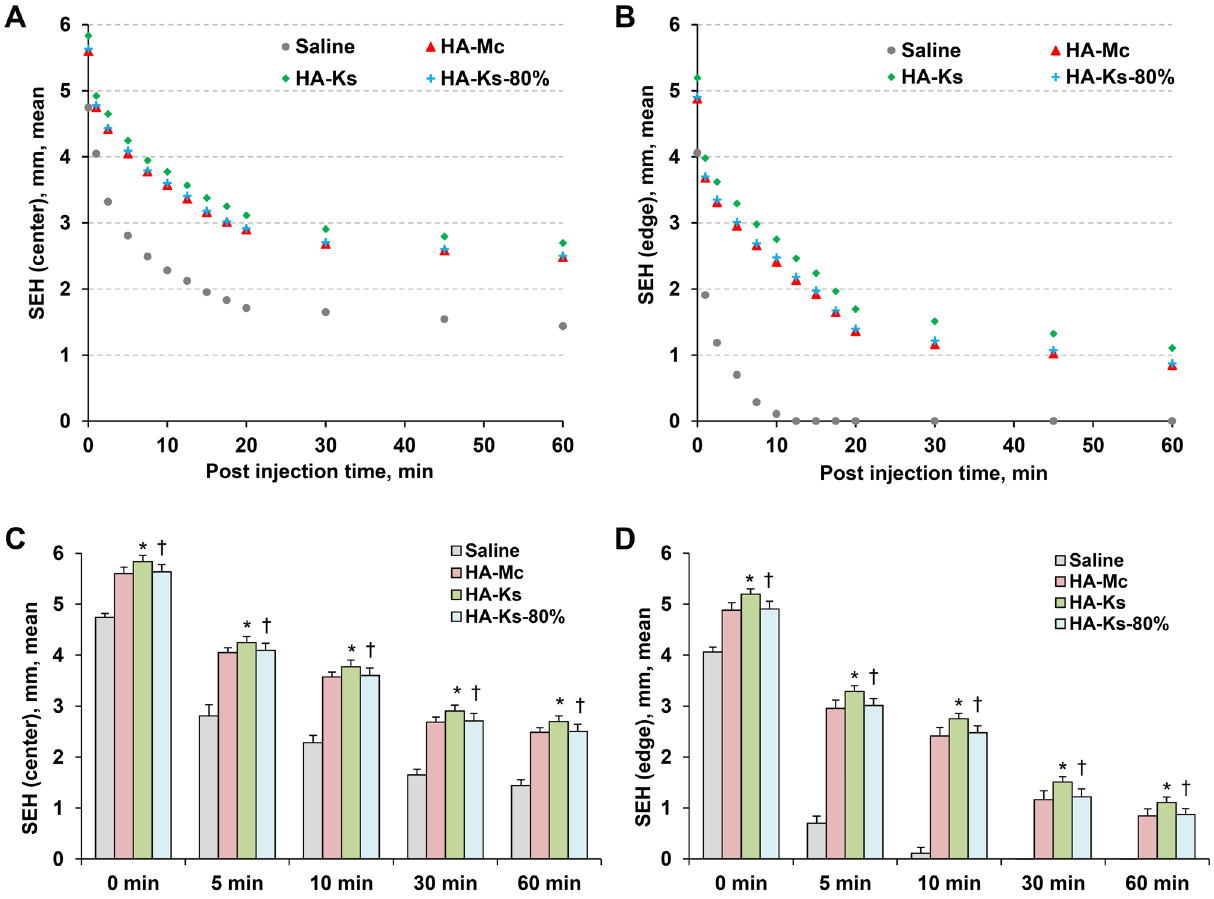
Figure 3. Comparison of submucosal elevation height (SEH) between saline, HA-Mc, HA-Ks, and HA-Ks-80%. ( A ) After injecting saline, HA-Mc, HA-Ks, or HA-Ks-80% into the submucosa at the center of specimens, the SEH was measured over time. ( B ) Saline, HA-Mc, HA-Ks, or HA-Ks-80% was injected at the edge of specimens instead of their center, and the SEH was measured over time. ( C, D ) Values of SEH measured at various post- injection times for saline, HA-Mc, HA-Ks, or HA-Ks-80% after injections at the center ( C ) and edge ( D ) of specimens are compared. SEH, submucosal elevation height; HA-Mc, sodium hyaluronate-based submucosal injection material (MucoUp); HA-Ks, sodium hyaluronate-based submucosal injection material (Ksmart); HA-Ks-80%, HA-Ks diluted to 80% concentration in saline. Data are expressed as mean ± standard deviations for at least five independent experiments. * P < 0.05 (HA-Mc vs. HA-Ks). † P > 0.05 (HA-Mc vs. HA-Ks-80%).